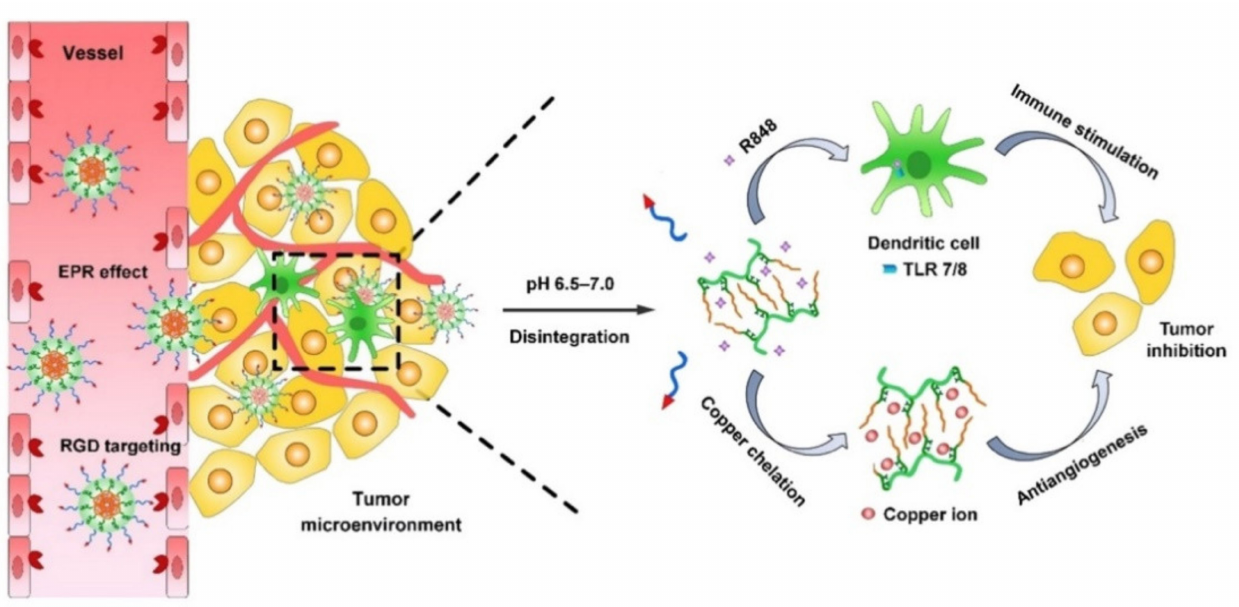
Figure 5. Combinative anti-tumor effect of R848 and TETA-DTC copper chelator. Reproduced with permission from ref. [90]. 2019